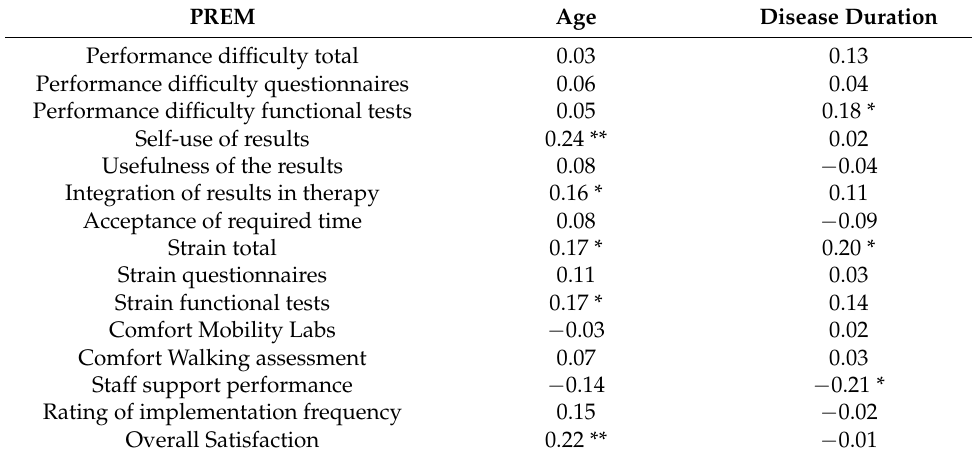
Table 4. Kendall’s Tau-b ( τ ) correlation between patient-reported experience measures and demo- graphic characteristics ( N =